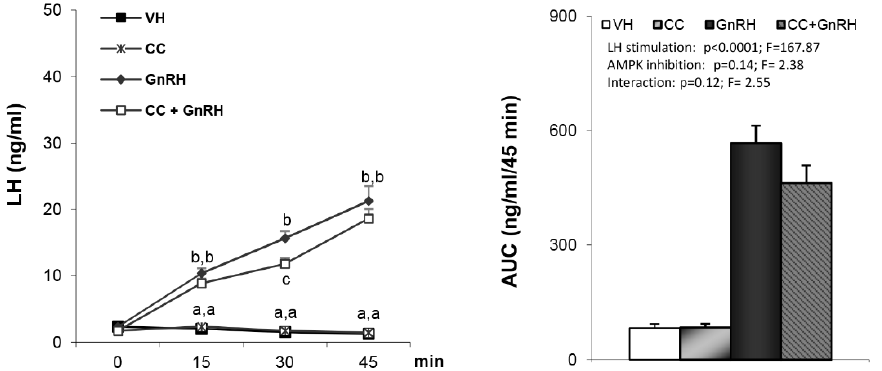
Figure 2. Levels of luteinizing hormone (LH) secretion and AUC after treatment with VH (5 µL DMSO icv plus 200 µL saline iv), CC (10 µg compound C icv plus 200 µL saline iv), gonadotropin-releasing hormone (GnRH) (5 µL DMSO icv plus 32.5 nmol/kg iv) or CC + GnRH (10 µg compound C plus 32.5